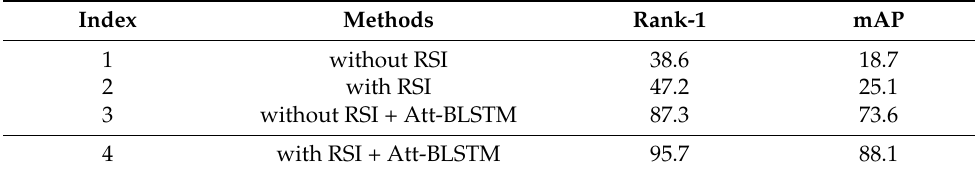
Table 5. The result of ablation